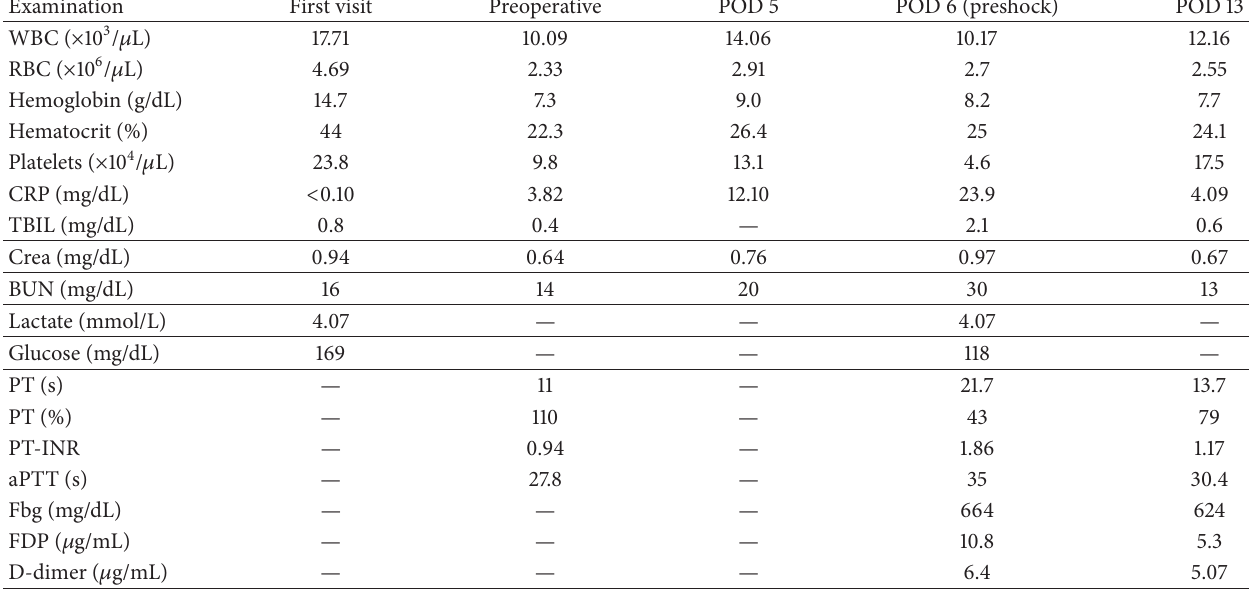
Table 1: Laboratory